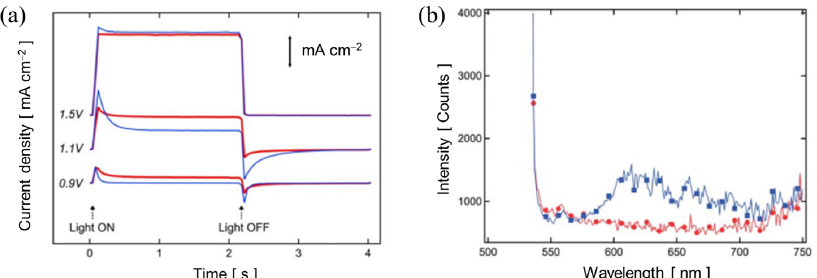
Figure 2. ( a ) Transient photoresponse shown by light chopping current densities (light on/light off) as a function of time. The bias potentials were applied for 4 s (2 s with light on and 2 s with light off) at 0.9, 1.1 and 1.5 V, as indicated. Comparison of the transient behavior of iron oxide photoanodes with 3 ALD cycles of Al 2 O 3 overlayer (red, thick line) and without (blue, thin line). ( b ) Photoluminescence emission spectra (excitation wavelength = 520 nm) of a hematite cauliflower ‐ type nanostructure photoanode before (red circles) and after 3 ALD cycles of Al 2 O 3 on its surface (blue squares). Reproduced from [26] with permission.